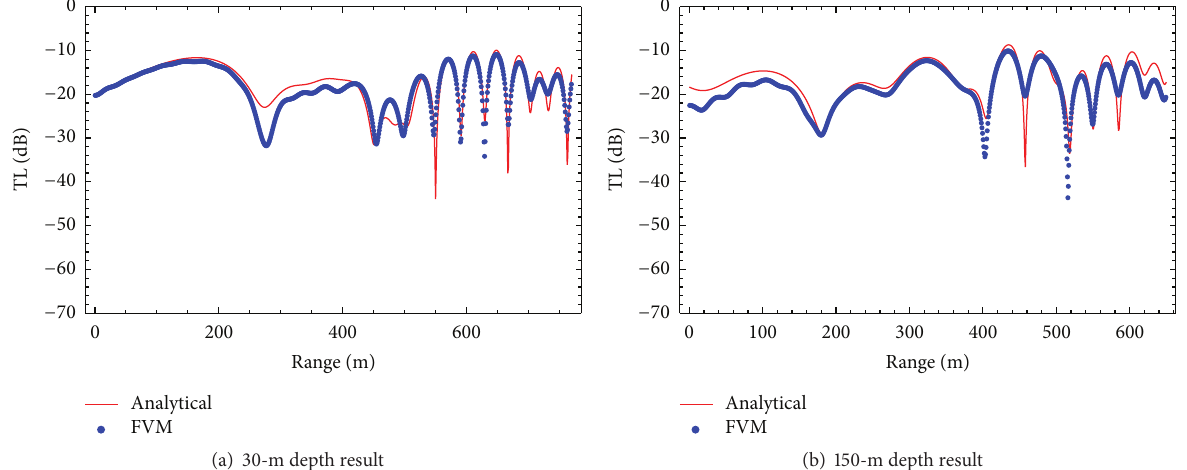
Figure 4: Comparisons of the Fourier transform of the FVM simulation and the analytical solution to the rigid bottom problem: (a) TL result at depth of 30 m; (b) TL result at depth of 150m.